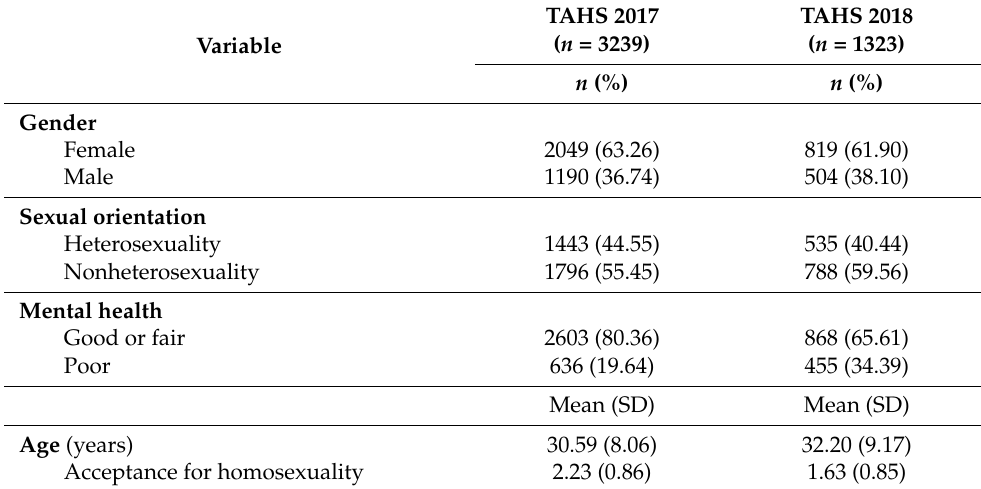
Table 1. Gender, sexual orientation, mental health status, age, and perceived attitudes toward homosexuality in TAHS (Taiwanese Attitudes toward Homosexuality Survey) 2017 and TAHS 2018.